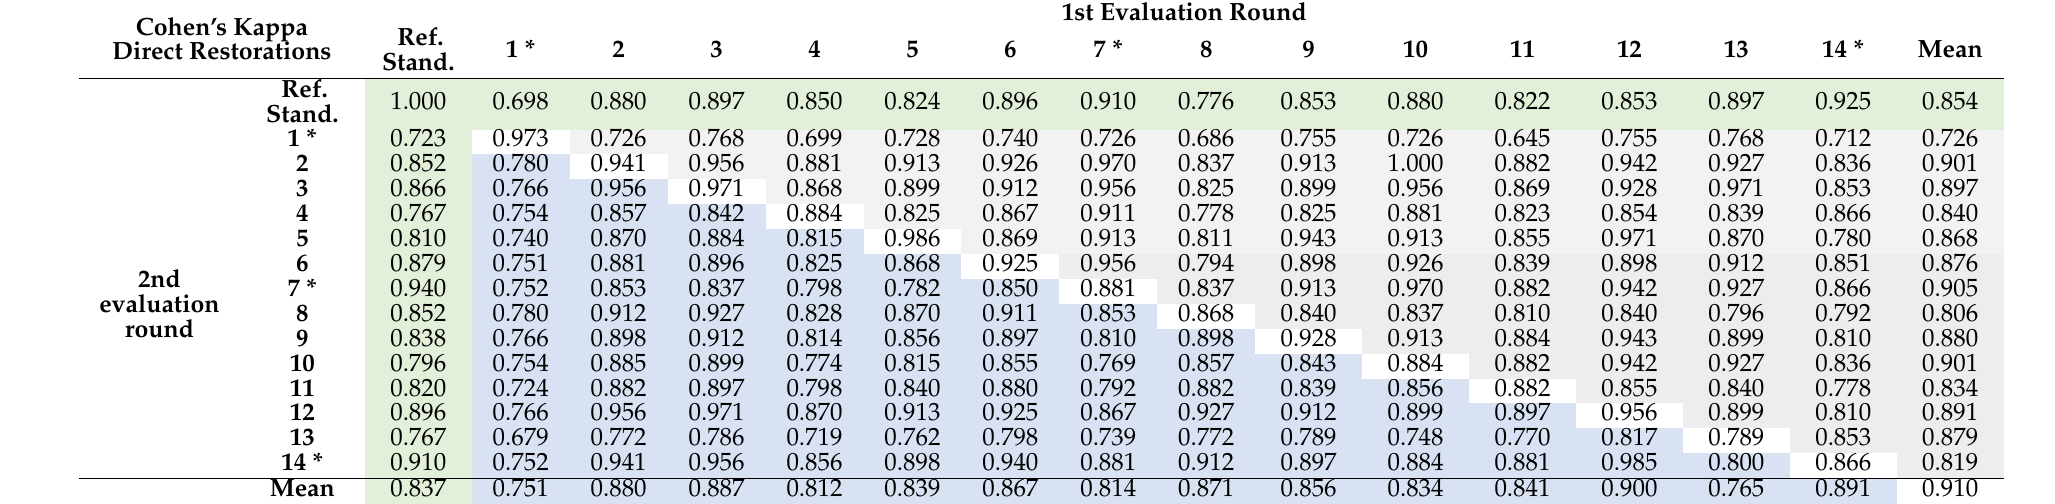
Table 1. Inter- and intra-examiner reliability values for the detection of direct restorations between all examiners (N = 14) and in relation to the reference diagnosis (green background color). Gray background colors indicate inter-examiner CK values of the first evaluation round and blue background colors for the second evaluation round. Fields with a white background color represent intra-examiner CK